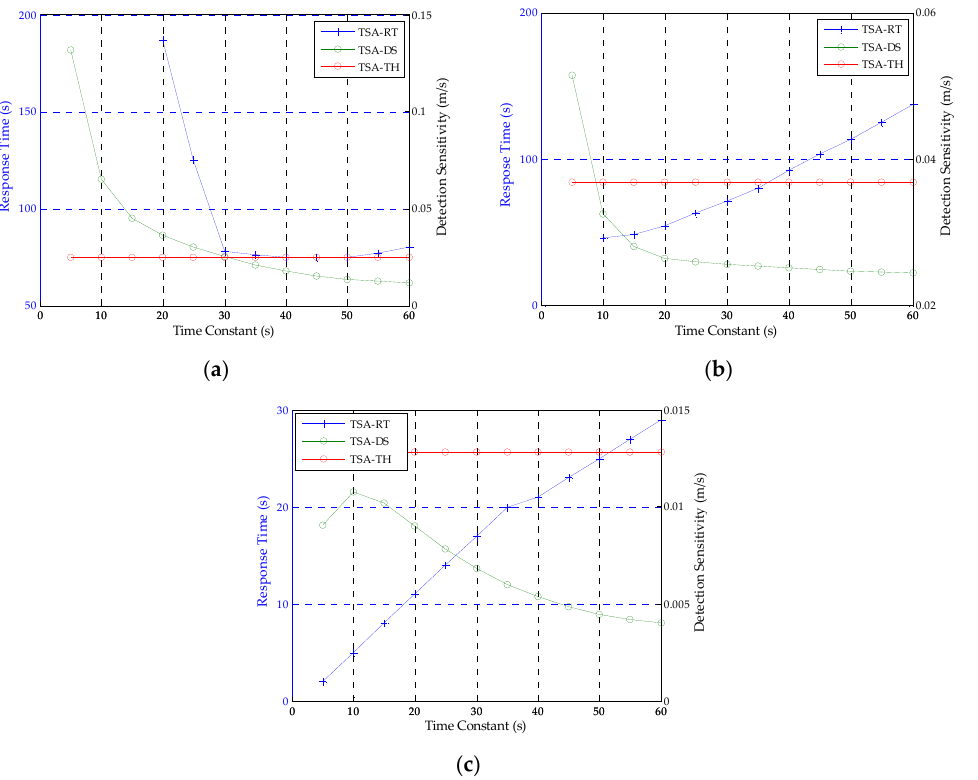
Figure 6. ( a – c ) The relationship of TSA between the time constant and response time, detection sensitivity, when 0 < ele ≤ 30 , 30 < ele ≤ 50 , 50 < ele ≤ 90 , respectively. Table 3. Time constant of TSA for different elevation groups chosen depending on 31 satellites being visible.